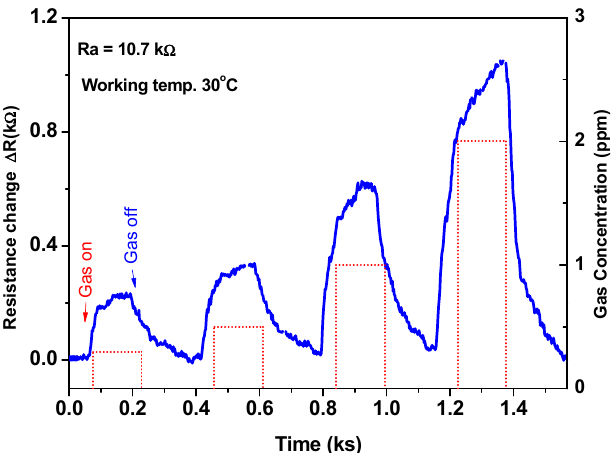
Figure 7. The sensor signal as a function of time at various gas concentrations.